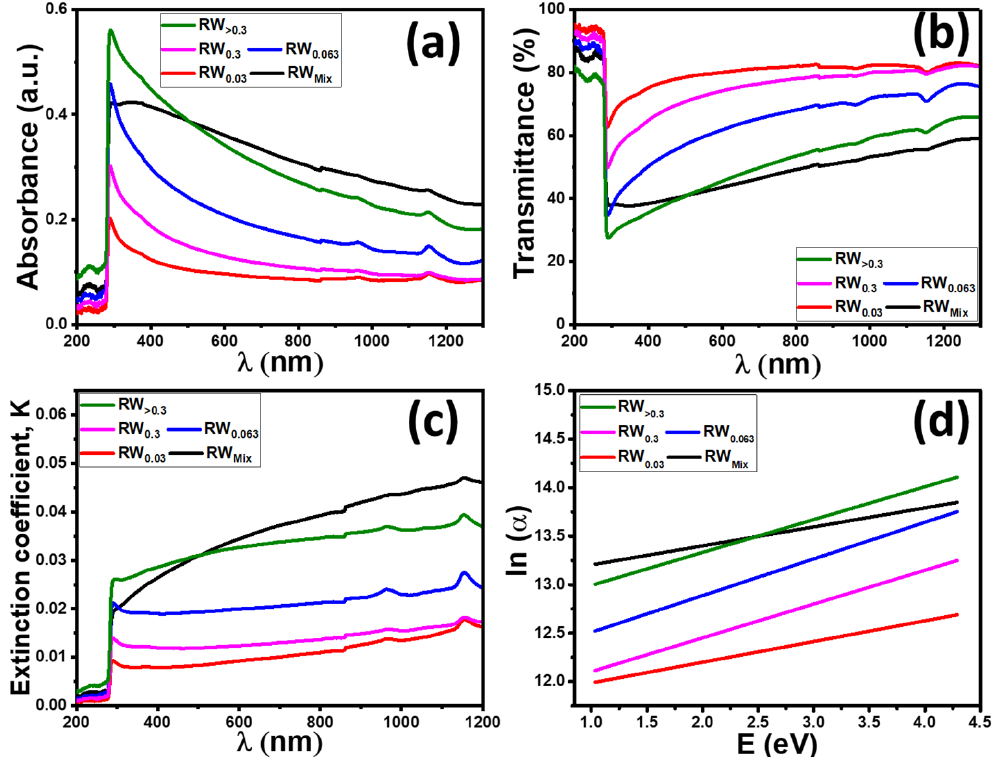
Figure 5. Optical spectra of RW nanostructured ( a ) absorbance, ( b ) transmittance, ( c ) ln( α )-E to determine Urbach energy (E U ); and ( d ) the extinction coefficient for the fabricated RW as a function of the wavelength.